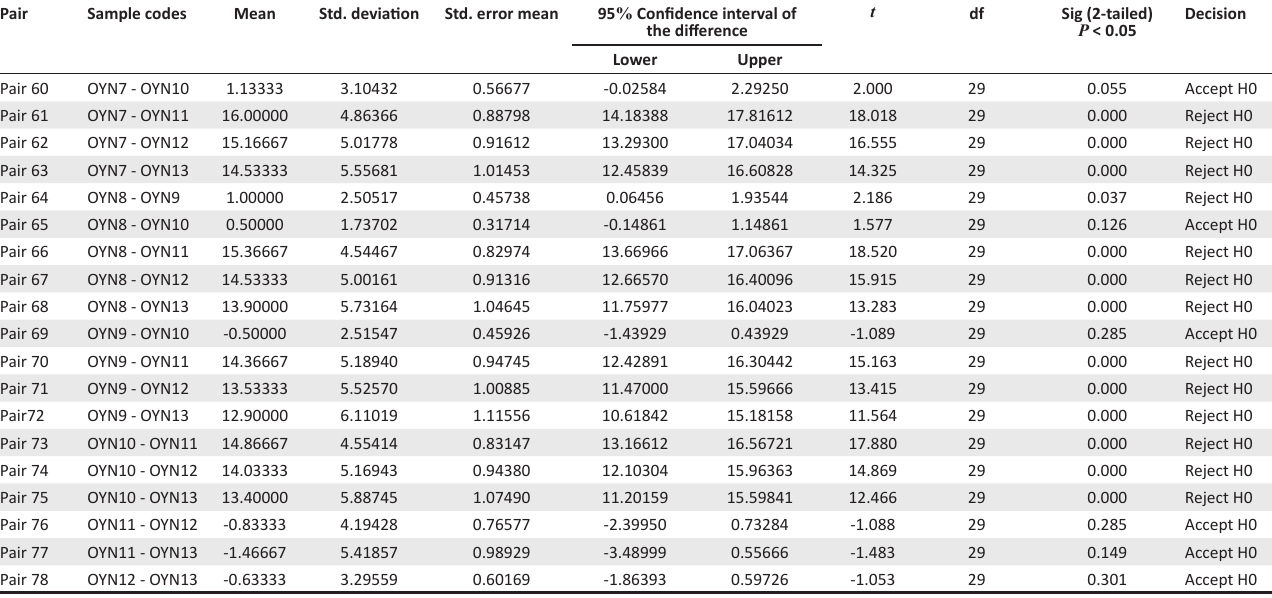
TABLE 1 (Continues...): Comparative analysis of the inhibition zones produced by the different soap samples. Pair Sample